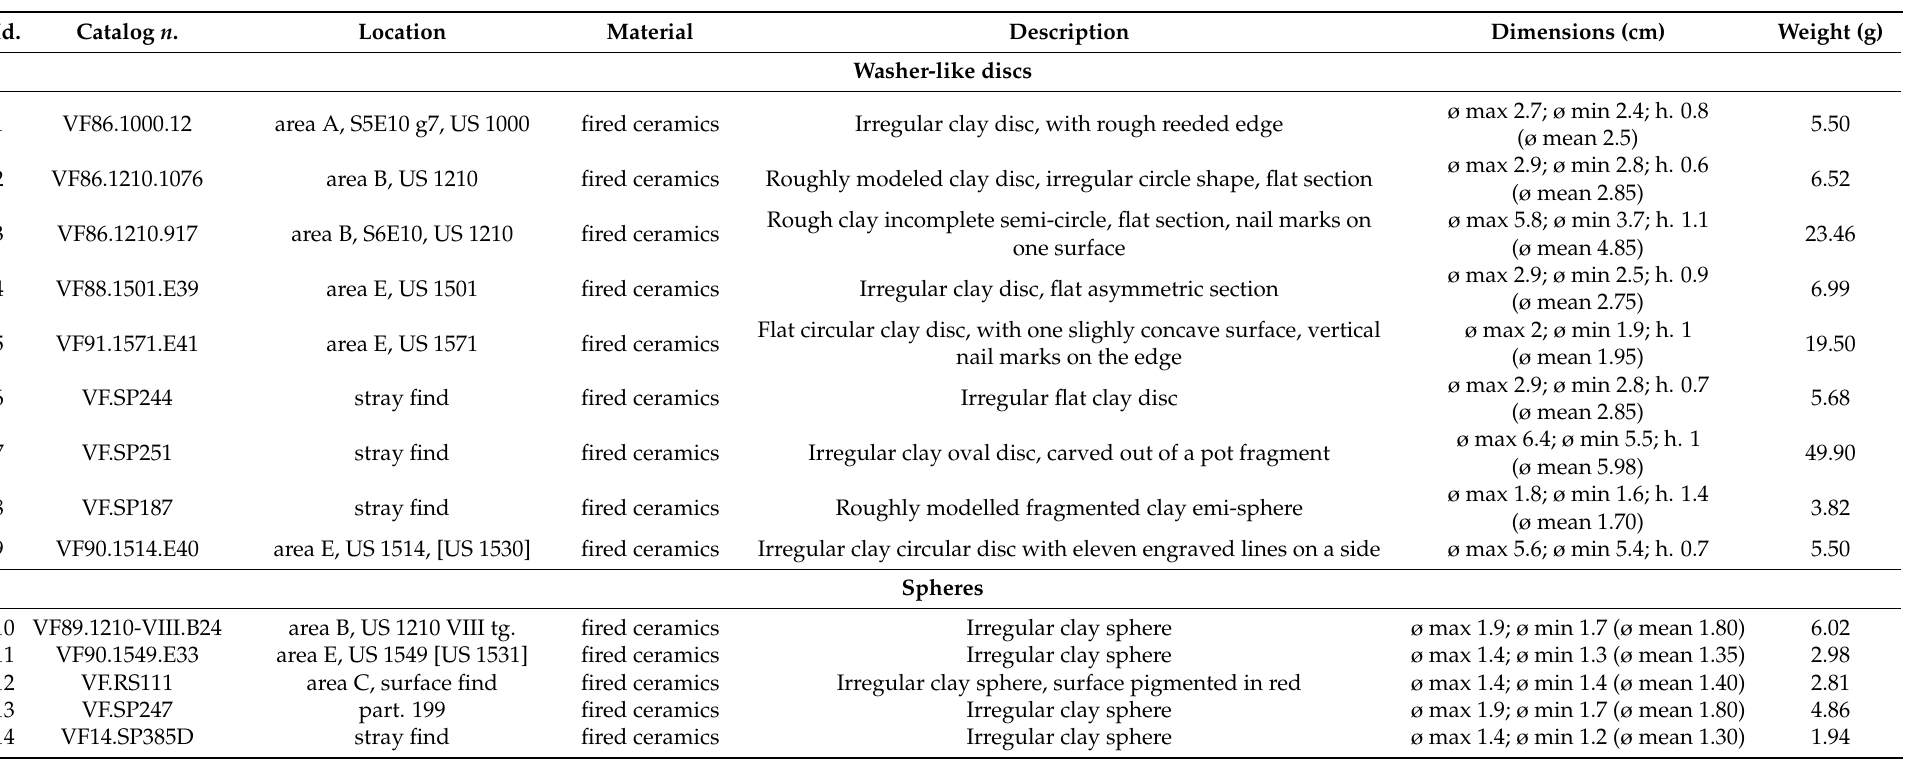
Table 1. List of investigated materials from Villa del Foro (Alessandria, Italy).